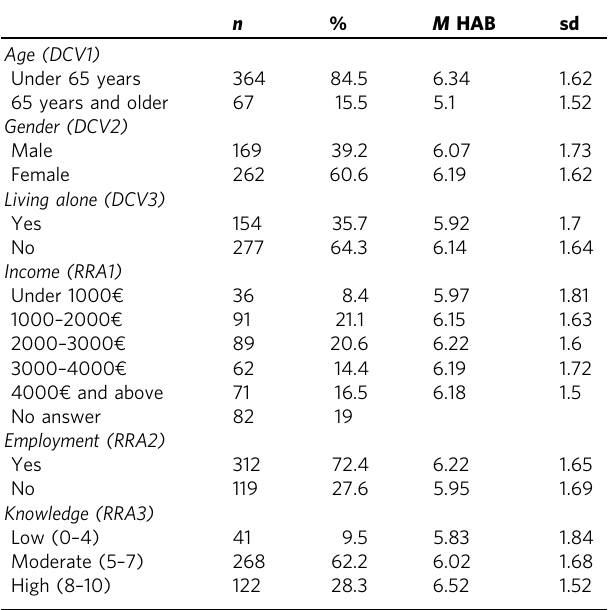
Table 9 Descriptive statistics of data sample ( N = 431) and heat adaptation